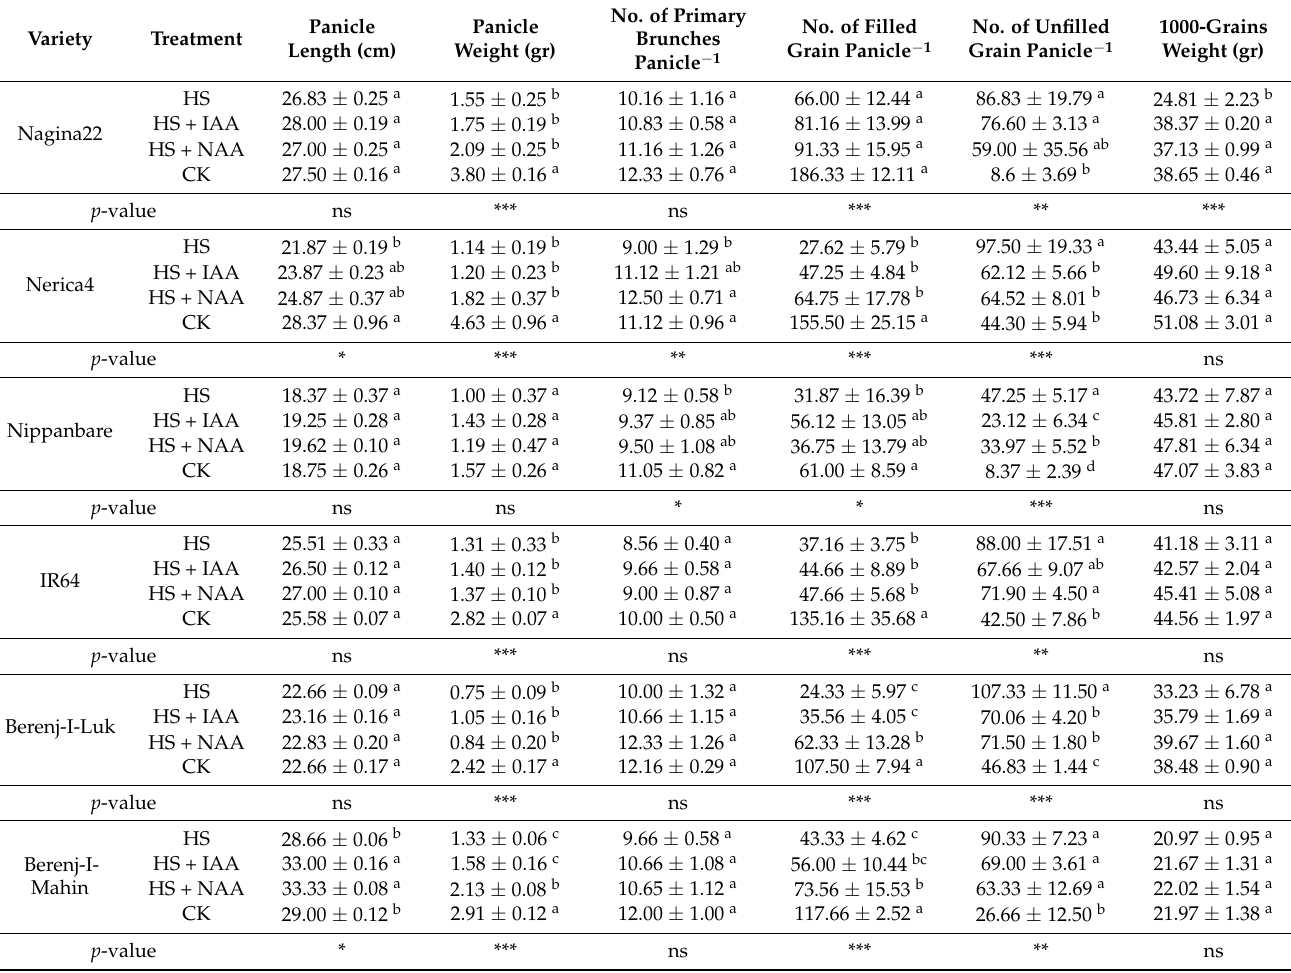
Table 2. Yield components of six rice genotypes under HS, HS + IAA, HS + NAA, and CK